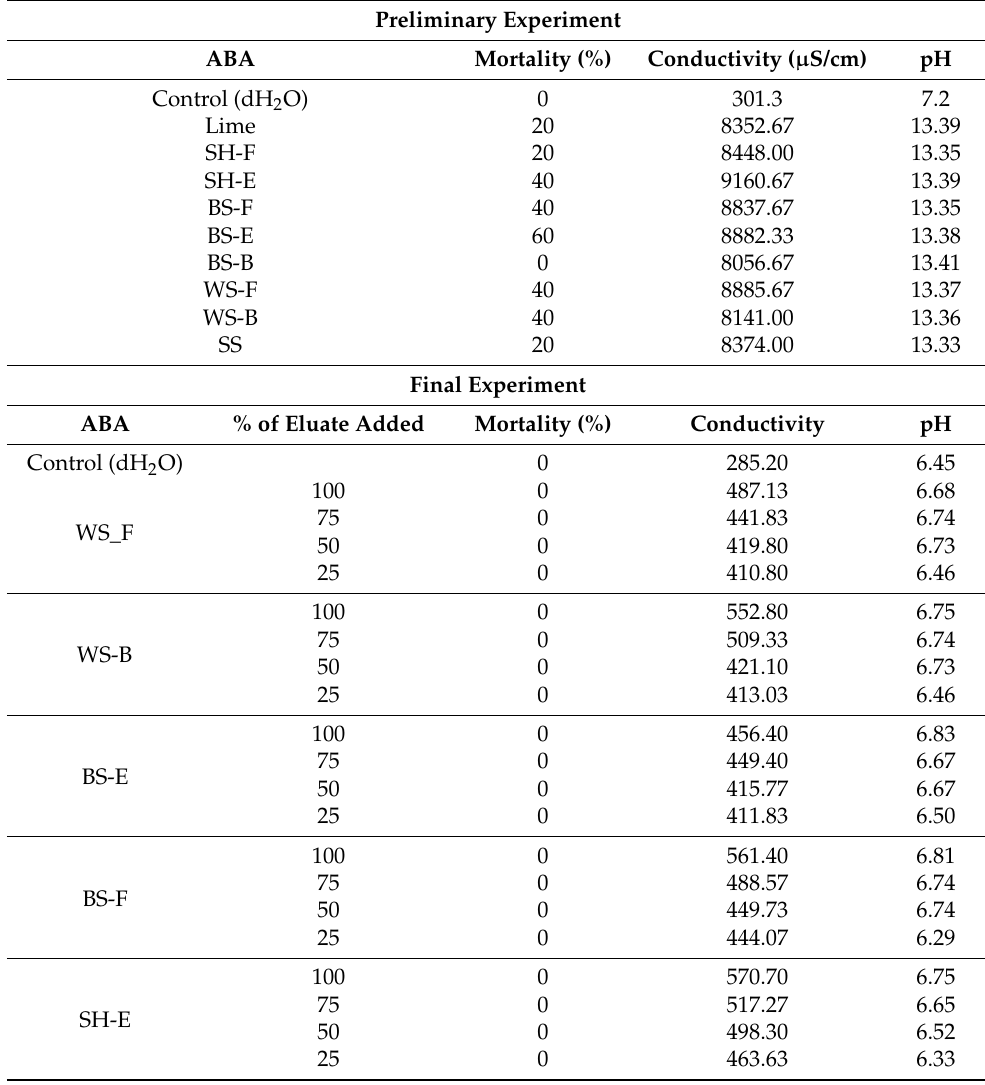
Table 9. Mortality rates of earthworms, pH and conductivity values of eluates in preliminary and final experiments with